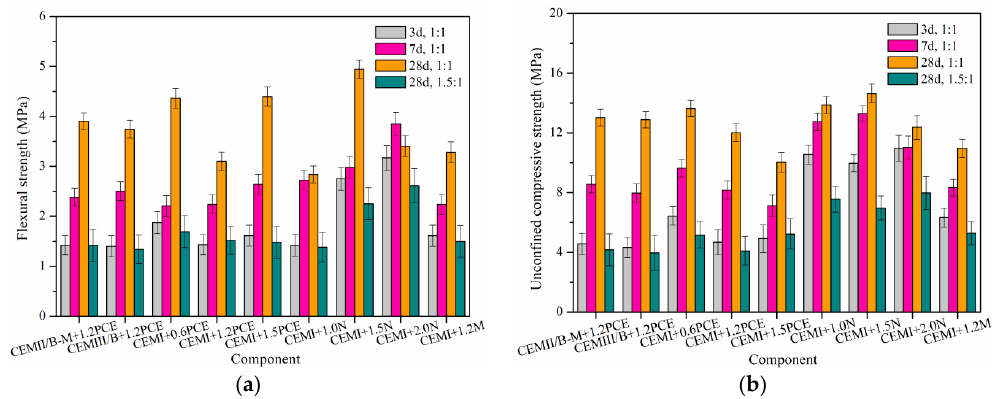
Figure 12. Shrinkage of SMCG stone bodies with different cement type, SP type and SP content at 30% R.H.